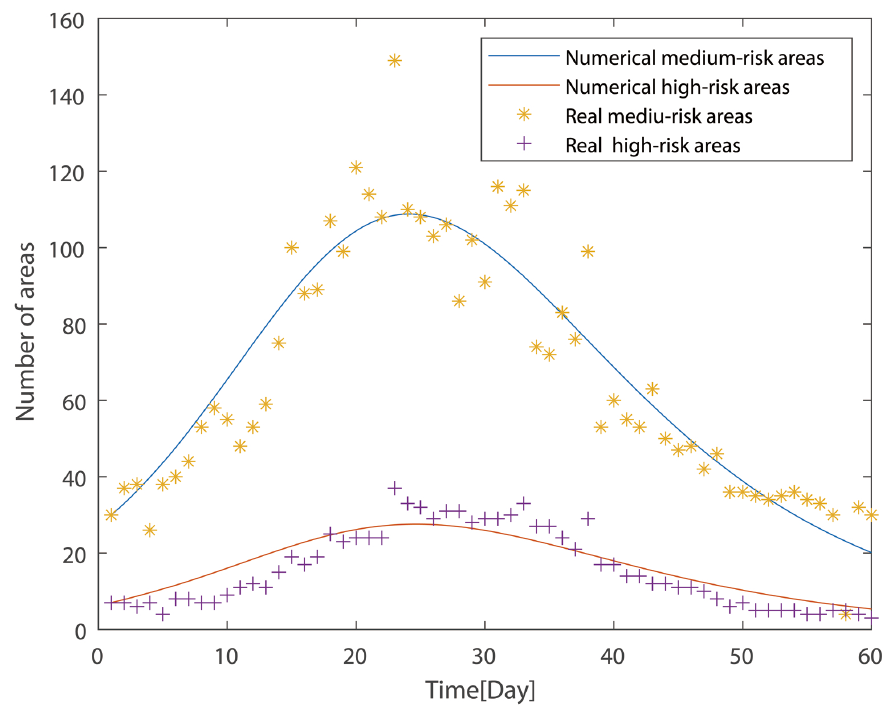
Figure 4. The simulation of the risk area transmission since 1 March 2022 in China. The stars and crosses represent the real Medium-risk and High-risk areas. The lines represent numerical Medium-risk and High-risk areas fit with the